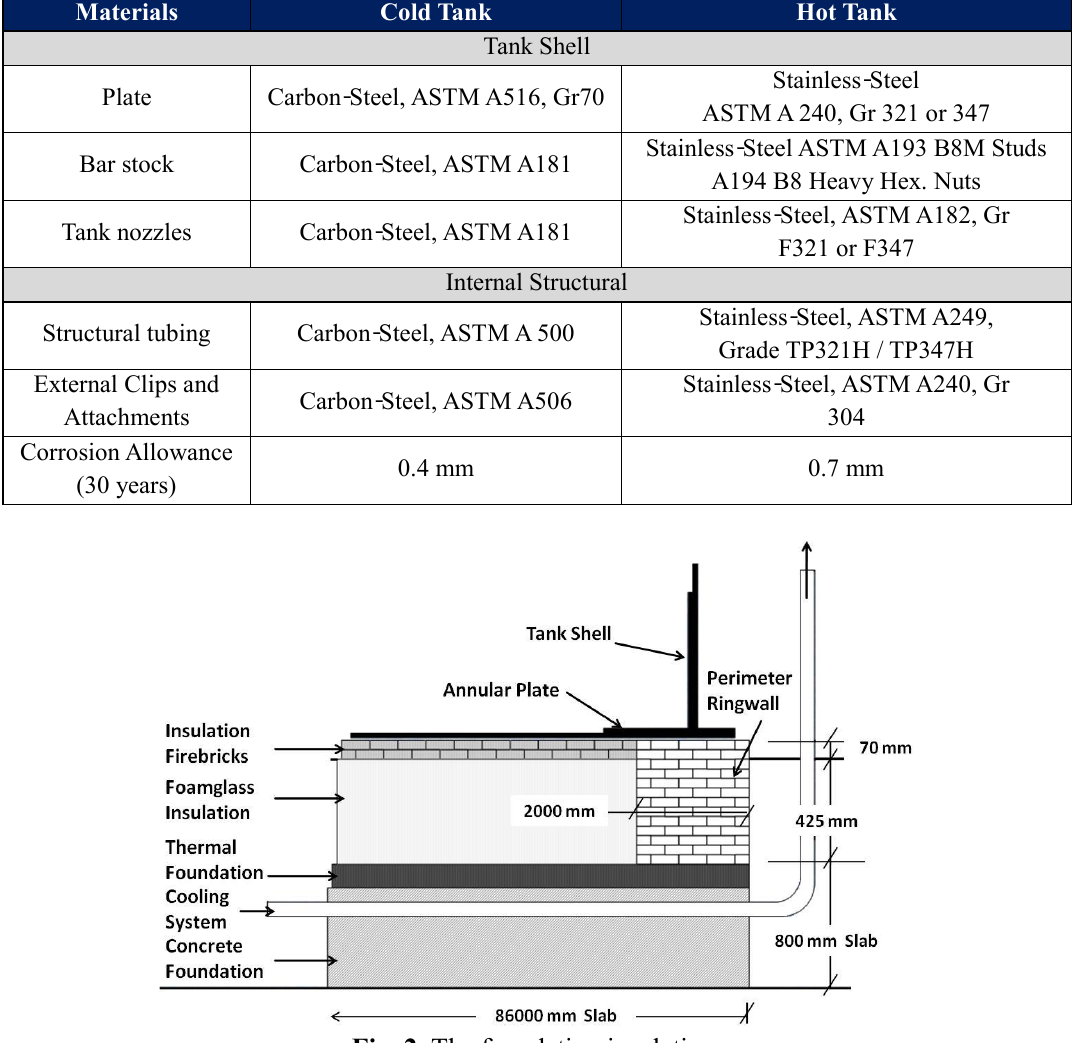
Tank materials selection.